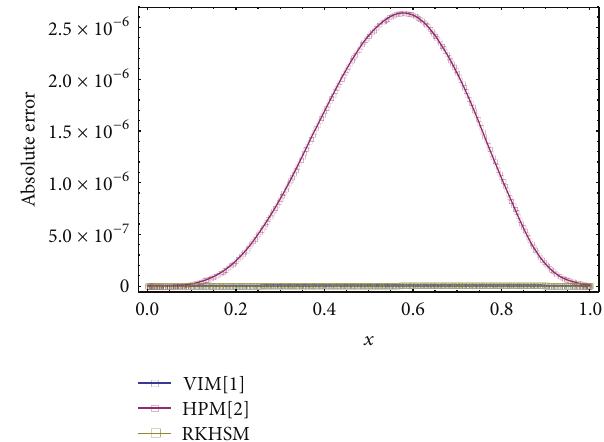
Figure 2:Comparisonofabsoluteerrorof VIM,HPM,and RKHSM for Example